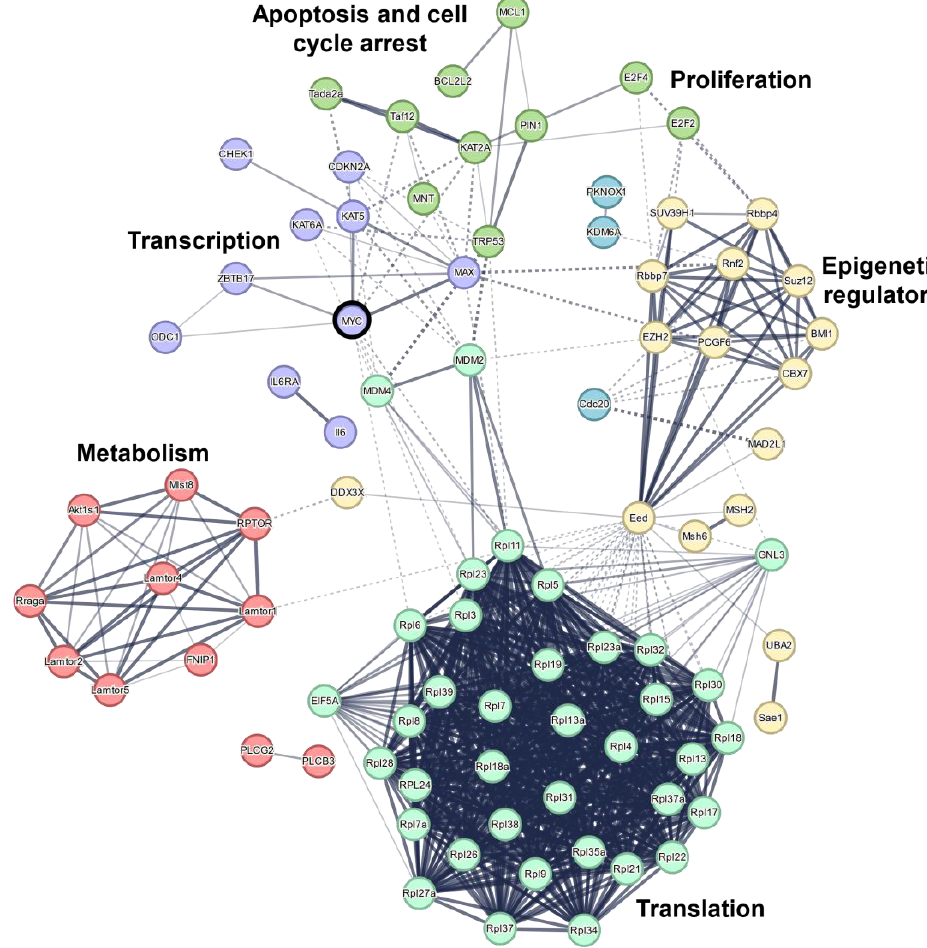
Figure 4. Common effectors of MYC-induced lymphomagenesis physically interact. Critical genes from Figure 2 were clustered based on the physical interaction of the encoding protein (line thickness indicates the strength of data support) of the encoded protein using the STRING database [102]. Additional common interaction partners are shown. Terms describe biological function of some proteins in the clusters.